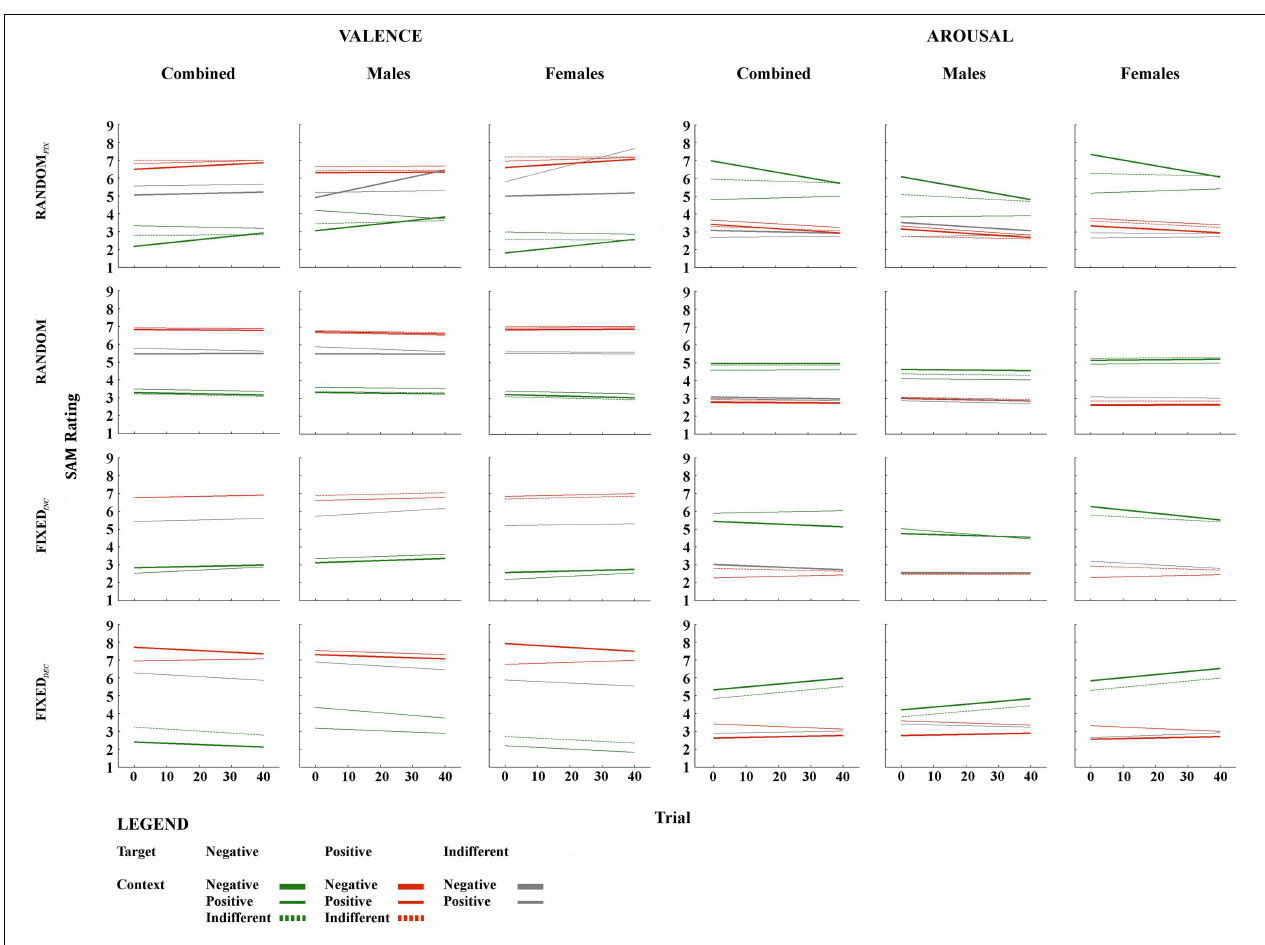
FIGURE 1 | Fixed effects of temporal context for valence and arousal. The figures are plotted using the intercept and slope estimates given in Tables 1 – 4 ; specifically, the intercepts given in the Intercept and Temporal Context columns, and the slope estimates given in the Trial and (where the interaction term was significant) Temporal Context * Trial columns. Abbreviations: Random FIX , The same randomized sequence presented to all participants; Random , A sequence randomized for each participant independently; Fixed INC , A fixed